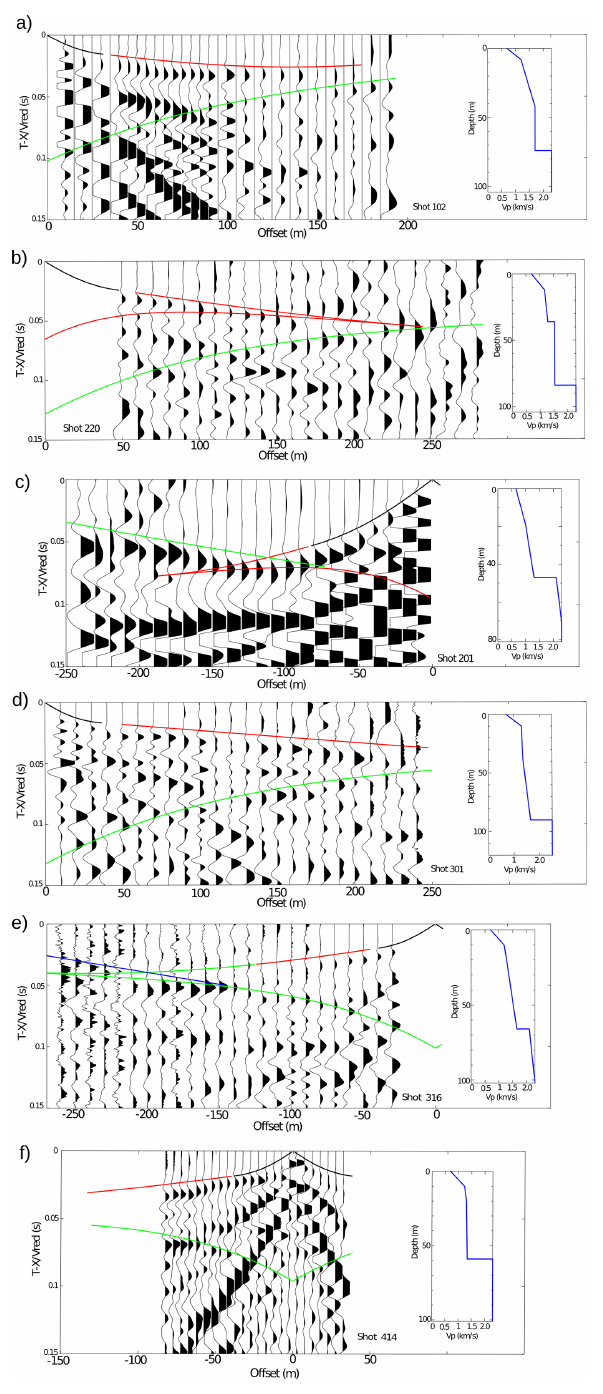
Figure 3. (a) Shot at − 10m, profile P1. (b) Shot at − 50m, pro- file P2. (c) Shot at 240m, profile P2. The reduction velocity is 1.5kms − 1 , and the horizontal coordinate is shot–geophone dis- tance (offset). (d) Shot at − 10m, profile P3. (e) Shot at 260m, profile P3 (f) Shot at 82.5m, profile P4. The reduction velocity is 1.5kms − 1 , and the horizontal coordinate is shot–geophone dis- tance (offset).